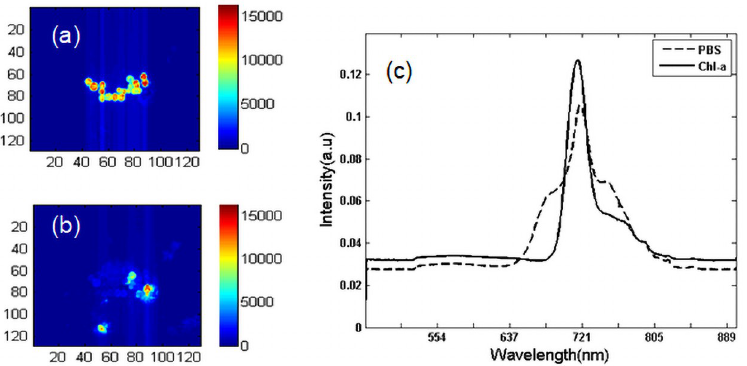
Fig 5. MCR analysis of Microcystis aeruginosa. (a) Concentration image of PBS resulting from analysis of the entire spectral area using MCR. (b) Concentration image of CHl-a resulting from analysis of the entire spectral area using MCR. (c) MCR pure-component spectrum containing the PBS component (dotted line) and chlorophyll-a (solid line). Color scales are identical for all images to facilitate comparison between images. The x-axis and y-axis of the image represent image size